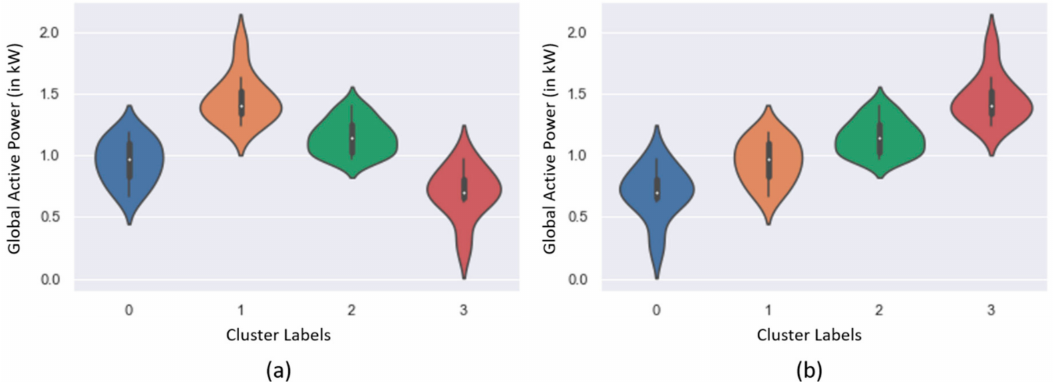
Figure 4. ( a ) The four clusters achieved by the proposed clustering technique, which were first randomly labelled with numbers ranging from 0 to 3, ( b ) The center of each cluster was identified and sorted in ascending order, which shows the proper numbers representing the level of